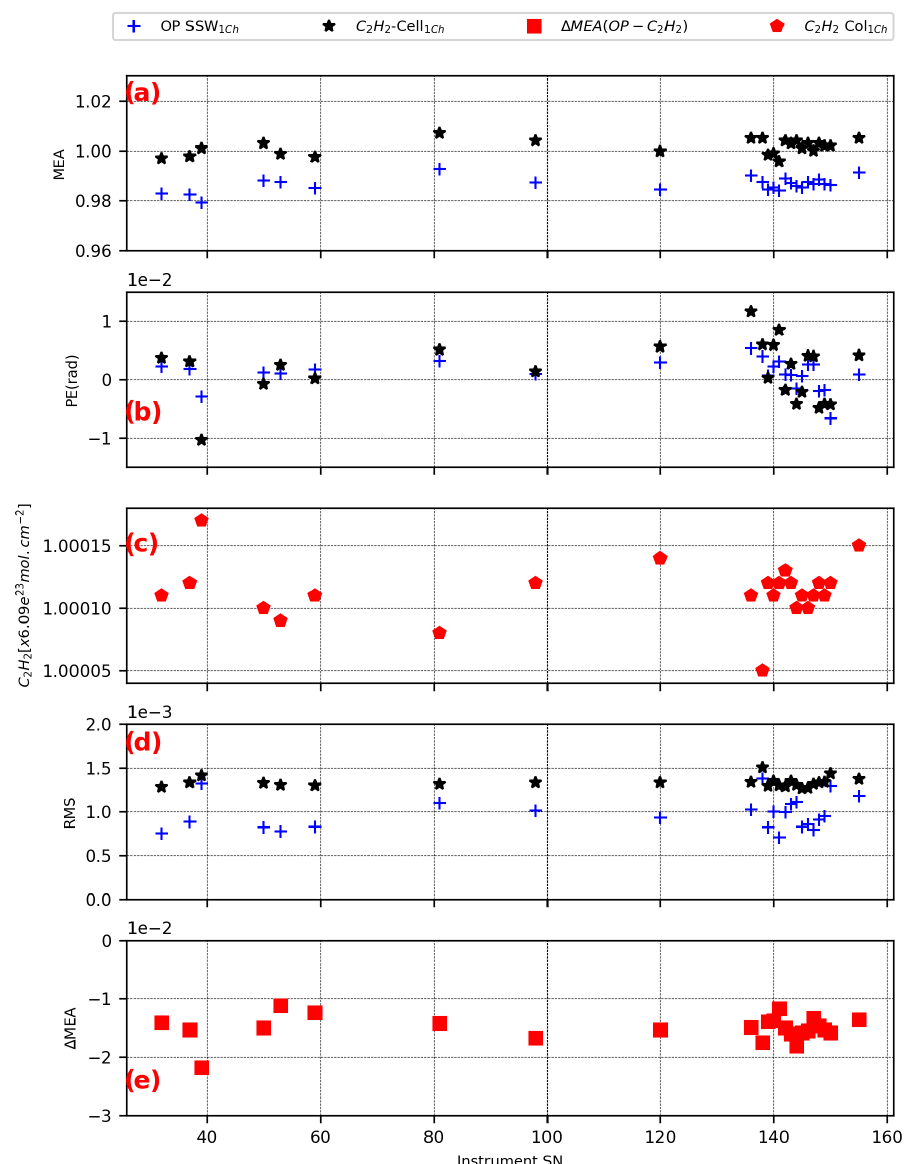
Figure 17. The modulation efficiency as a function of the instrumental SN, phase error, C 2 H 2 column, rms of the spectral fit and the relative difference between the open-path method and the cell method are presented in (a) , (b) , (c) , (d) and (e) ,